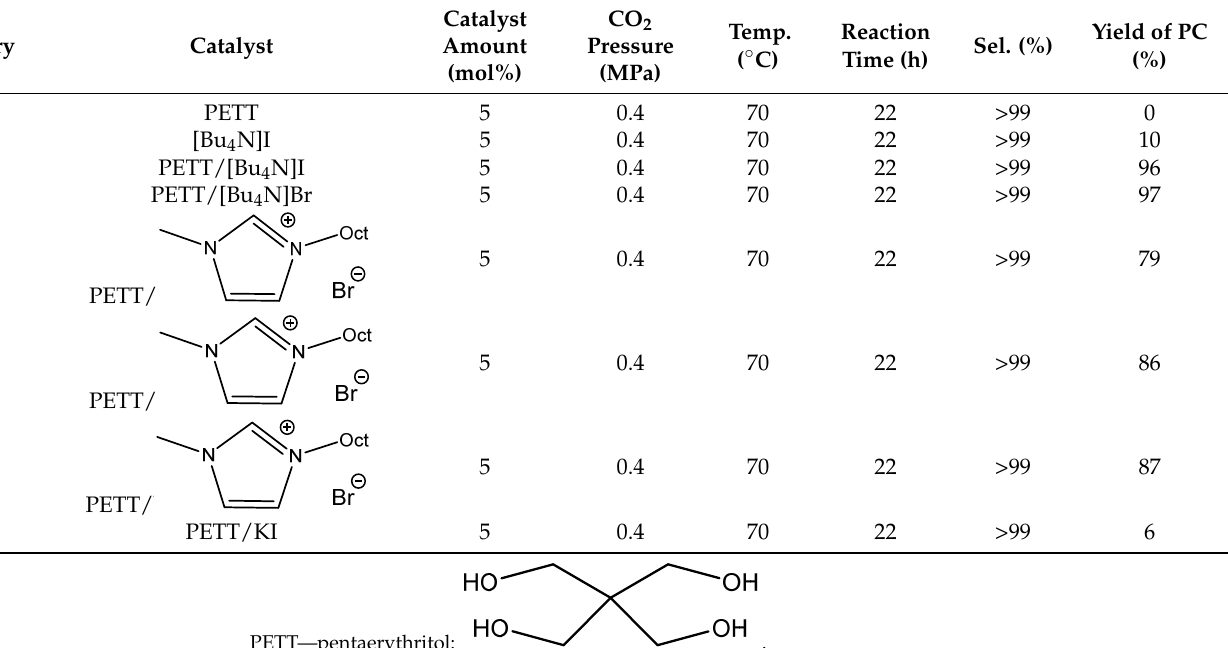
Table 19. Comparison of catalytic activities of DESs based on pentaerythritol (PETT) and Bu 4 NXs for the preparation of PC [80].